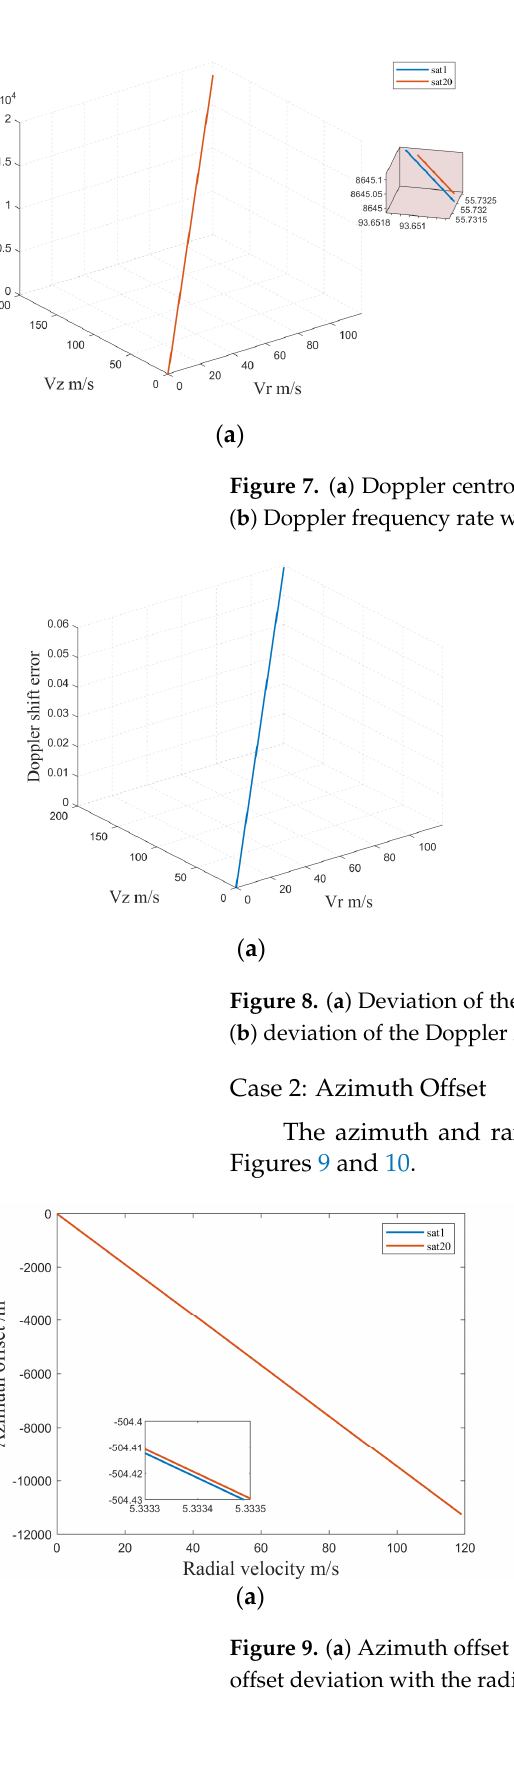
( b ) Figure 10. ( a ) Range offset with the radial velocity between the 1st and 20th images; ( b ) range offset deviation with the radial velocity between the 1st and 20th images. The azimuth direction of all 20 satellites is linearly related to the radial velocity, and the greater the velocity, the greater the offset. For a range velocity of 200 m/s, the differ- ence between the moving point and azimuth offsets of the 1st and 20th satellites is 0.035– 0.04 m. The offset difference is about 0.04 m, and the resolution is at the meter level. After registering the complete image, the moving target does not need additional registration. Case 3: Baseline Interval For different baseline intervals, the results are presented in Figure 11.